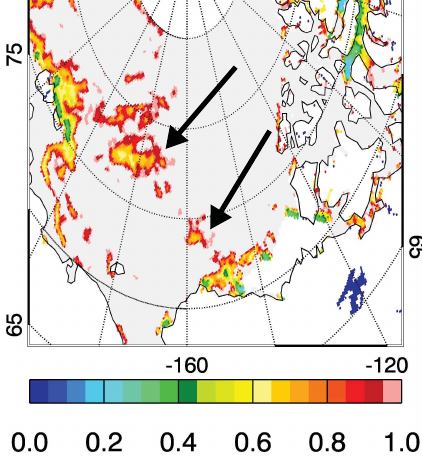
Figure 5. SMOS satellite retrievals of sea ice thickness [m] for 1 April 2011. Values larger than 1m are generally related to large uncertainties and are therefore shown in light grey colour. Potential bromine source regions (see Sect. 4) are indicated by black arrows.